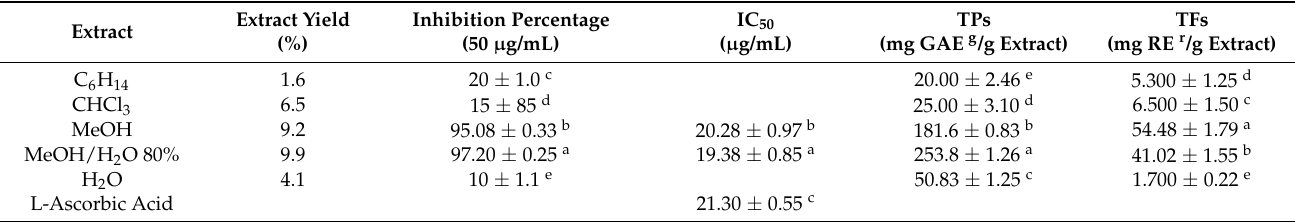
Table 2. Extraction yield, antioxidant activity (DPPH inhibition percentage), IC 50 , total phenolics (TPs), and total flavonoids (TFs) of R. gallica var. aegyptiaca leaf